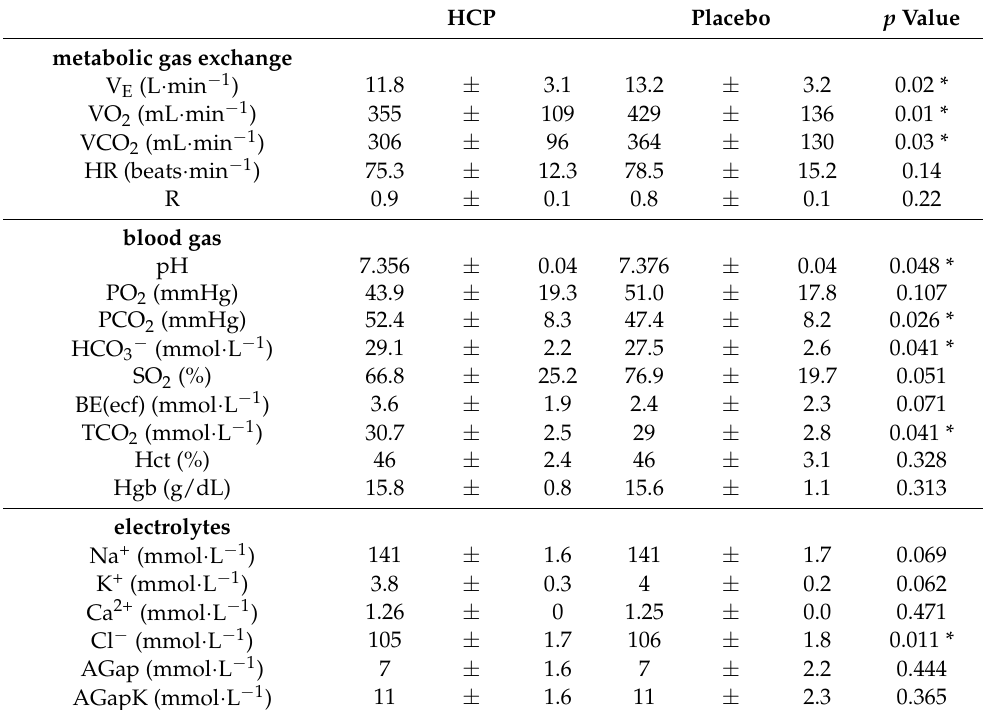
Table 1. Mean values of ventilatory, acid-base, and NIRS profiles at rest condition between the HCP and placebo